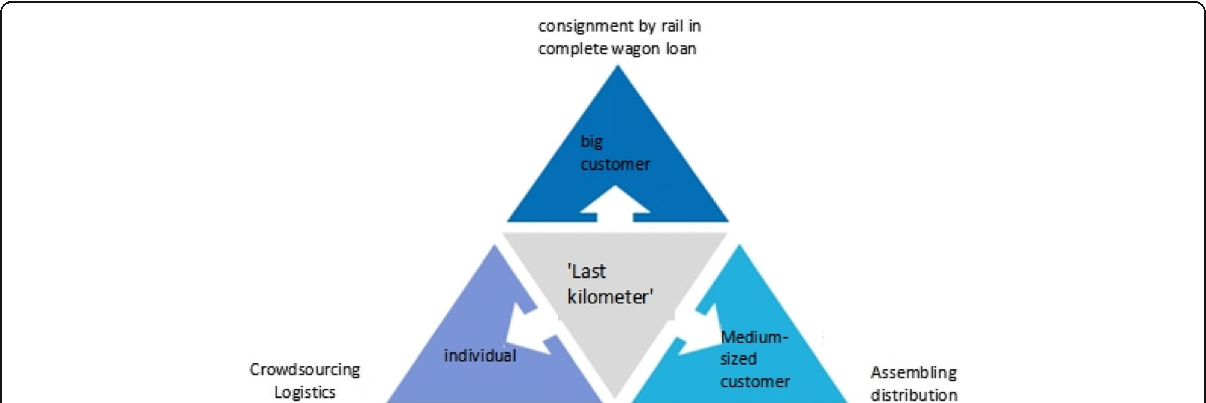
Fig. 2 Solution diagram for customers of different sizes. For three different sizes of customers, we should take different distribution methods. For large- sized customers, we should adopt the method of whole vehicle transportation. This method can improve the efficiency and speed of distribution. For medium-sized customers, it will be good to take the form of assembly distribution; it can make full use of logistics resources and reduce the transport mileage. Aiming at individual customers, it will be good to adopt crowdsourcing logistics, crowdsourcing logistics can make full use of social